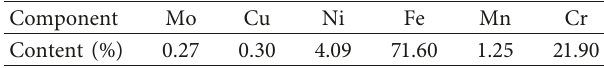
Table 1: Compositions of stainless steel